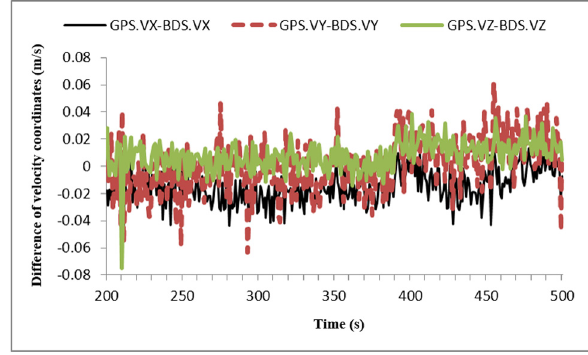
Figure 3: Di ff erence between BDS and GPS velocity coordinate.